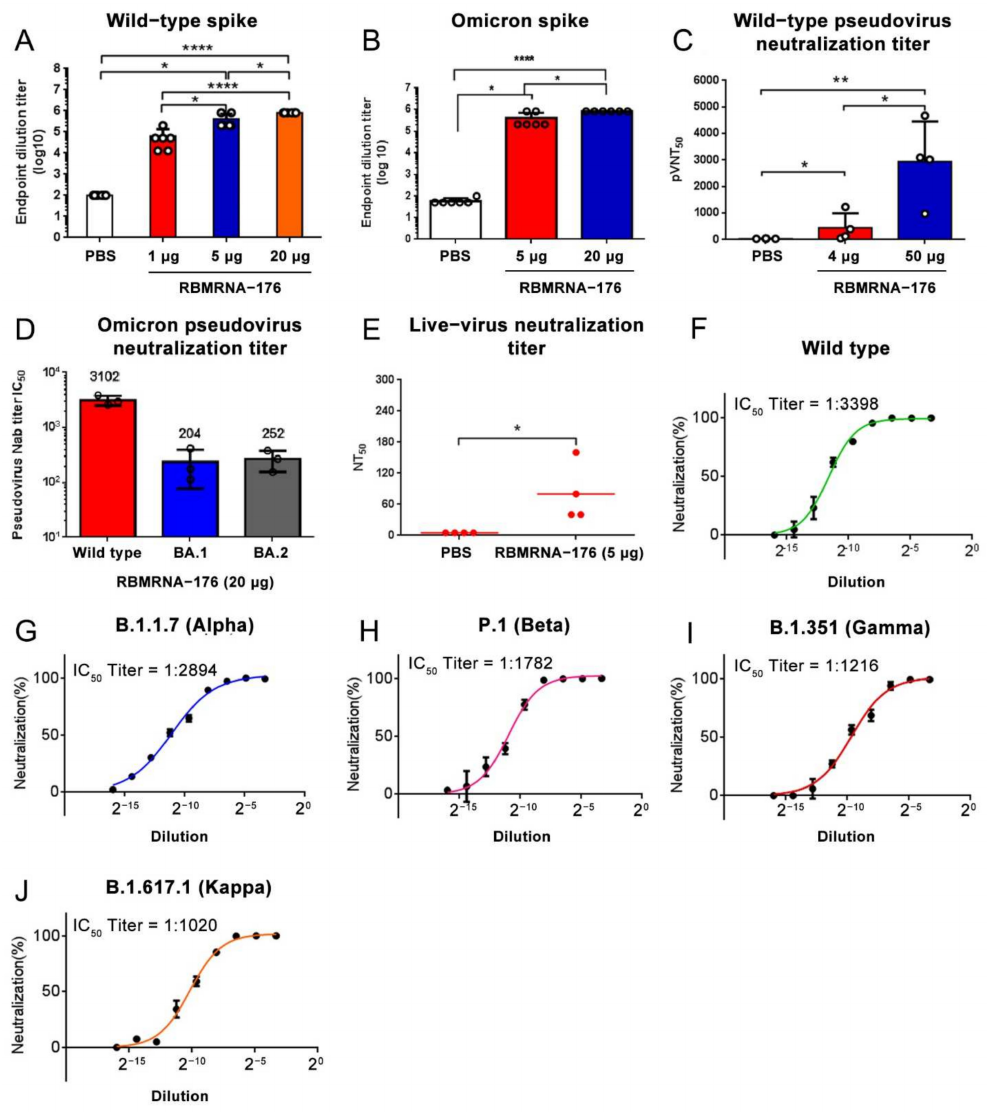
Figure 2. Humoral immune responses in RBMRNA-176-vaccinated mice. BALB/c mice were vacci- nated with three doses of RBMRNA-176 (1, 5, or 20 µ g) at an interval of 21 days. At week 2 after